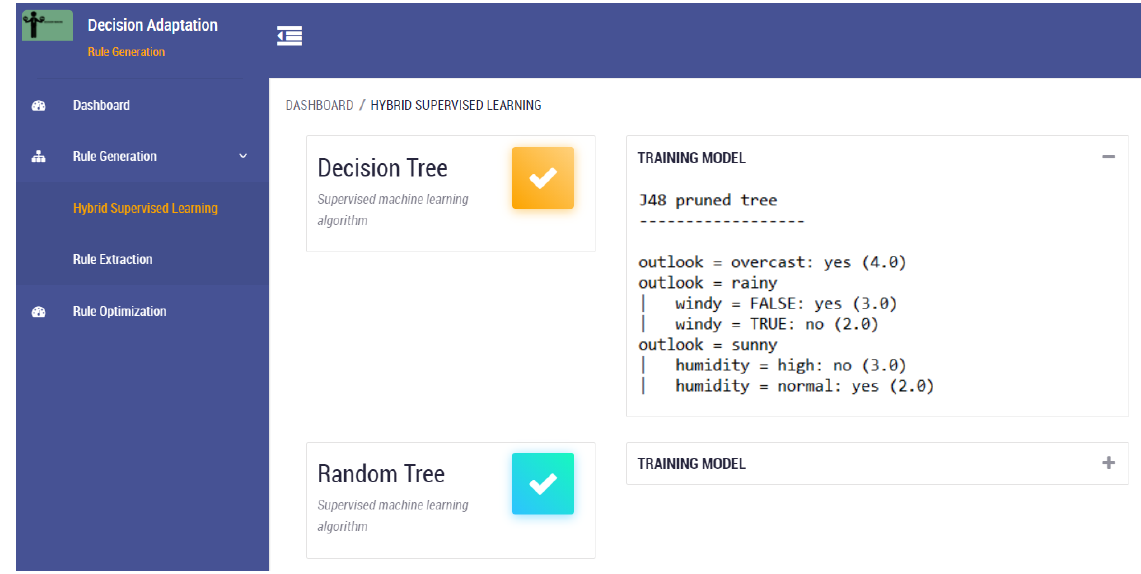
Figure 5. Tree-structured training model of the Decision Tree